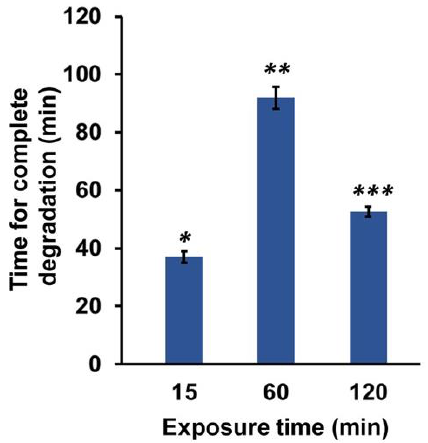
Figure 3. Enzymatic degradation of Gelatin-Ph/HA-Ph hydrogel by a mixture of hyaluronidase (1 mg/mL) and collagenase (1 mg/mL). The composite hydrogel was prepared by exposing air containing H 2 O 2 for 15–120 min into PBS containing 3 wt% Gelatin-Ph/0.5 wt% HA-Ph and 1 U/mL HRP. Bar: S.E. ( n = 3). * p < 0.005, 15 min compared to 60 min; ** p < 0.01, 60 min compared to 120 min; *** p < 0.01, 15 min compared to 120 min. Tukey HSD.